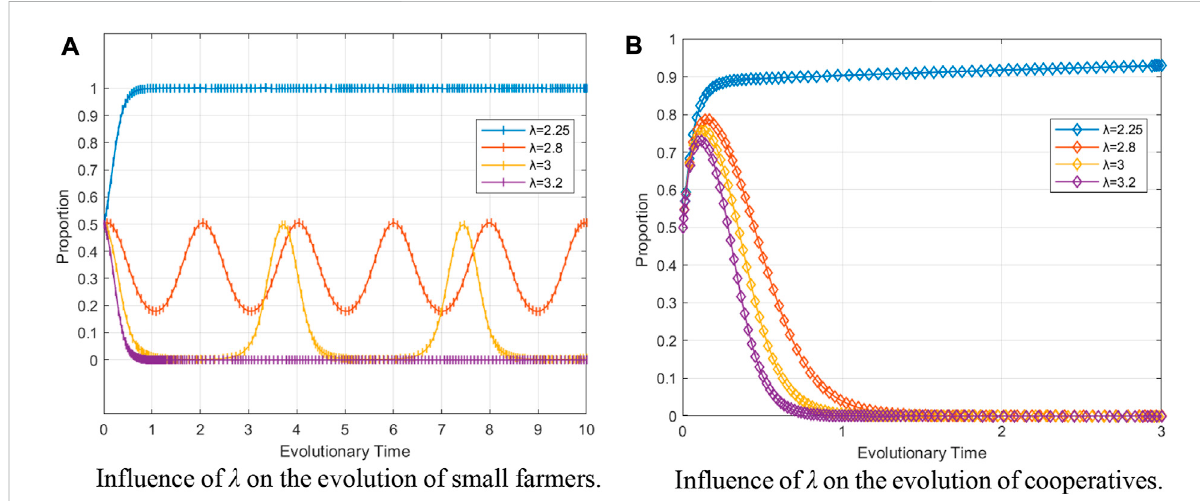
FIGURE 9 (A) In fl uence of λ on the evolution of small farmers. (B) In fl uence of λ on the evolution of